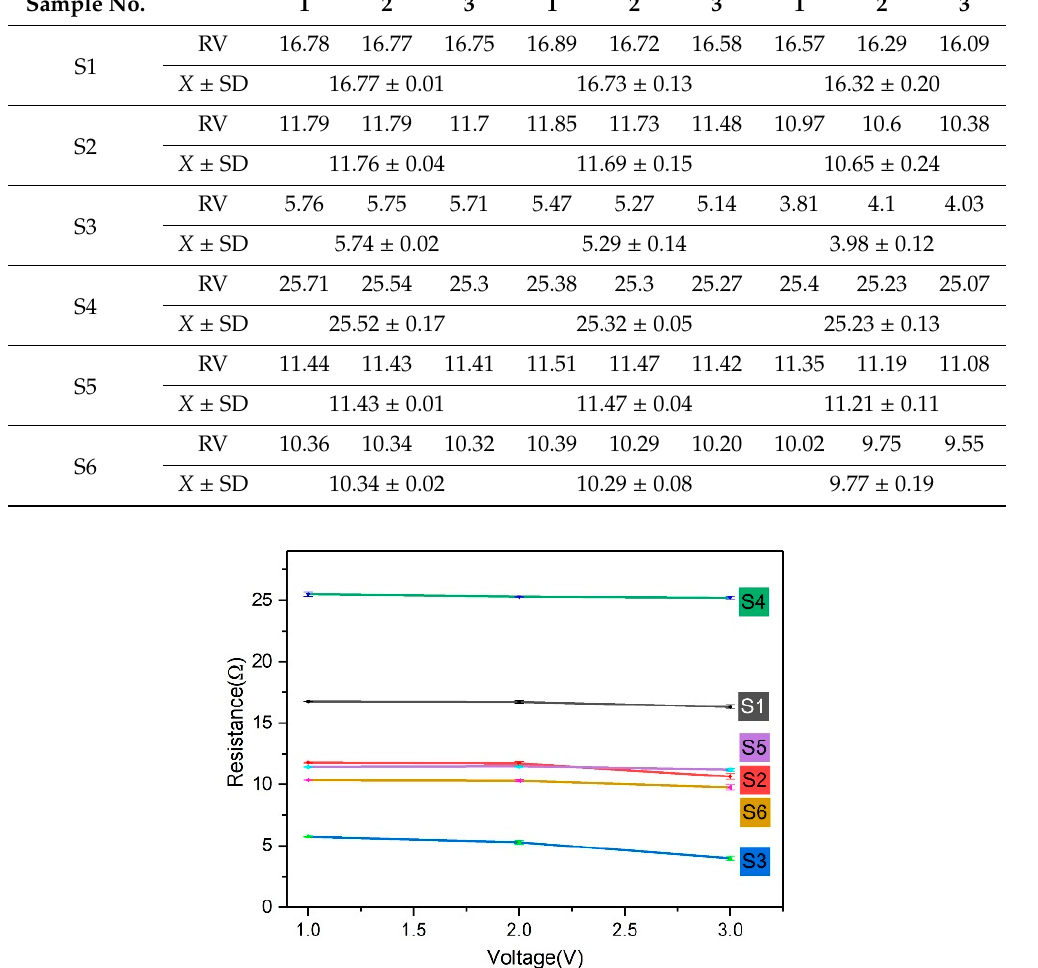
Table 3. Resistance values (RVs) and standard deviations (SDs) of S1–S6 at 1, 2, and 3 V. Sample No. Voltage